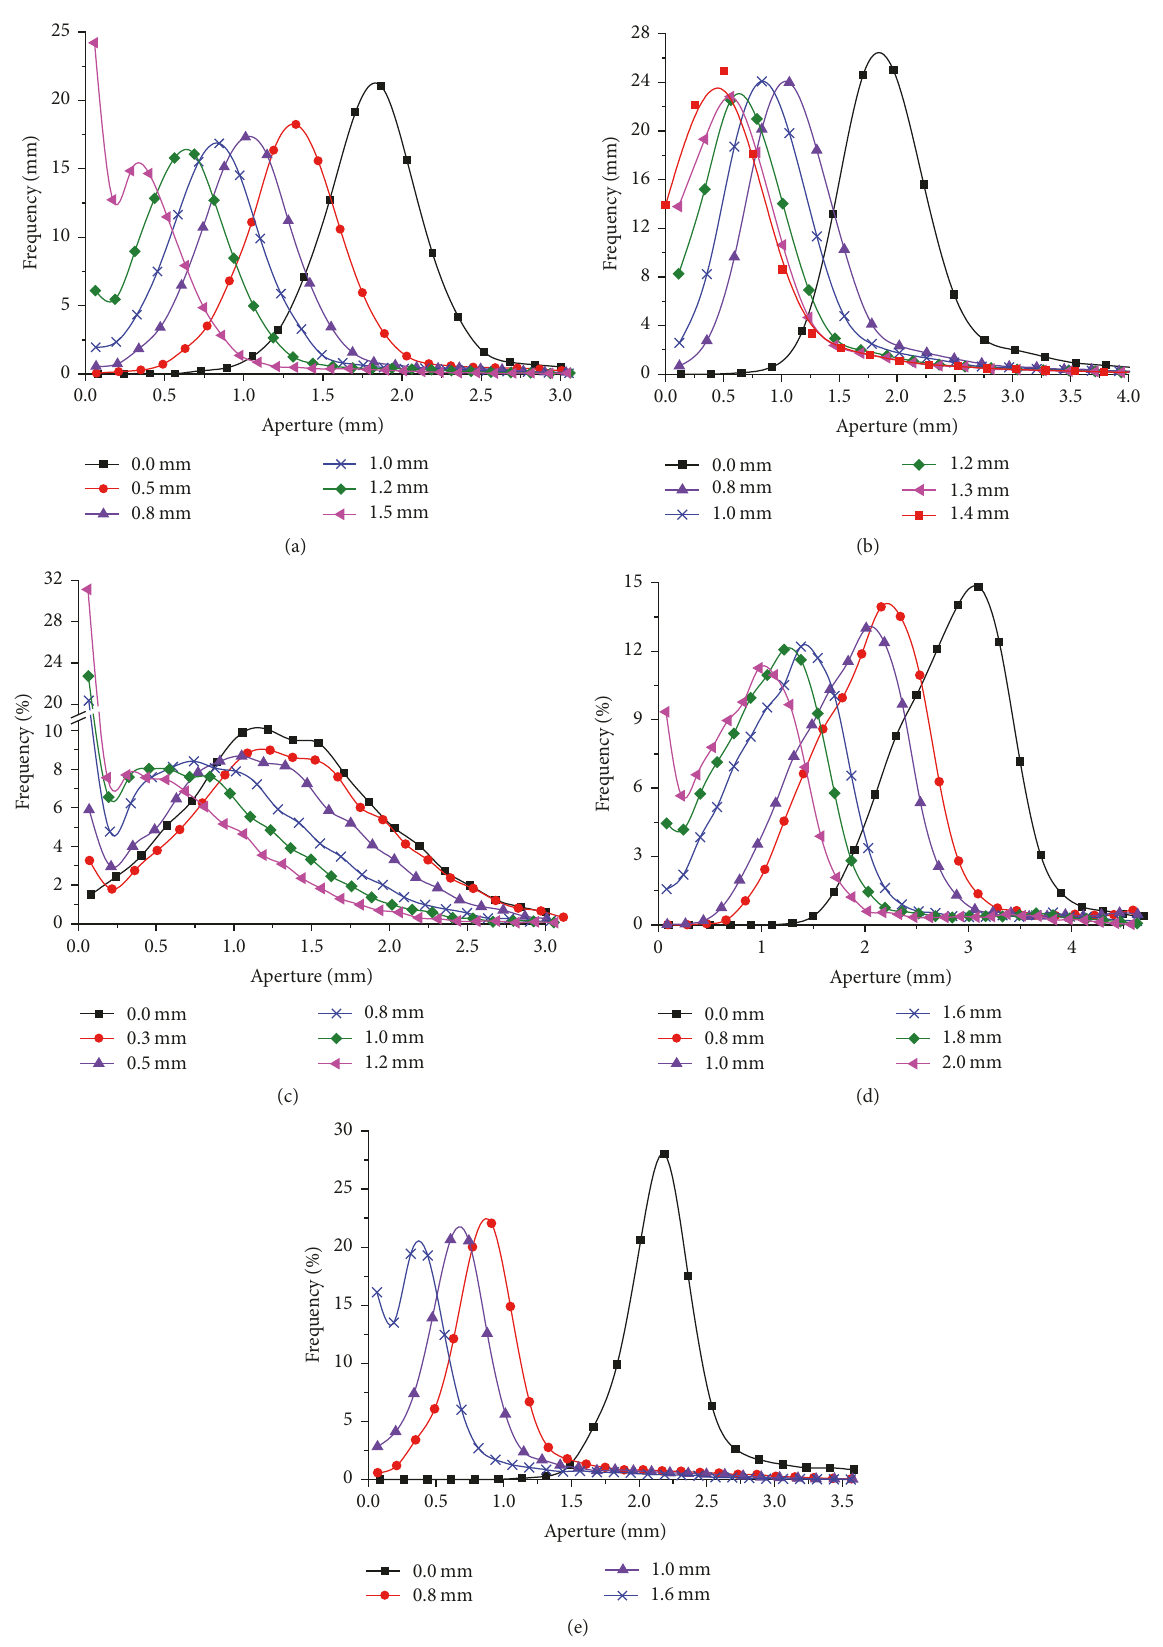
Figure 6: The frequency histograms of the aperture distributions of specimens (a) Gr1, (b) Gr2, (c) Gr3, (d) Gr4, and (e) Gr5 during